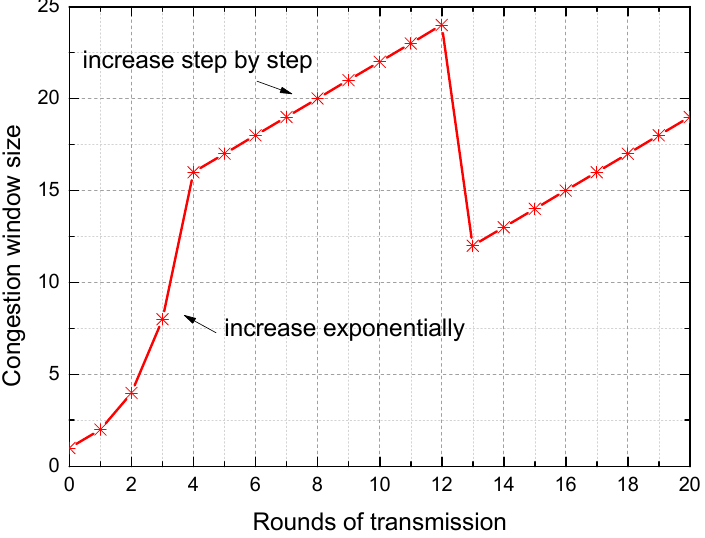
Figure 1. The change in congestion window size of slow starts and the congestion avoidance